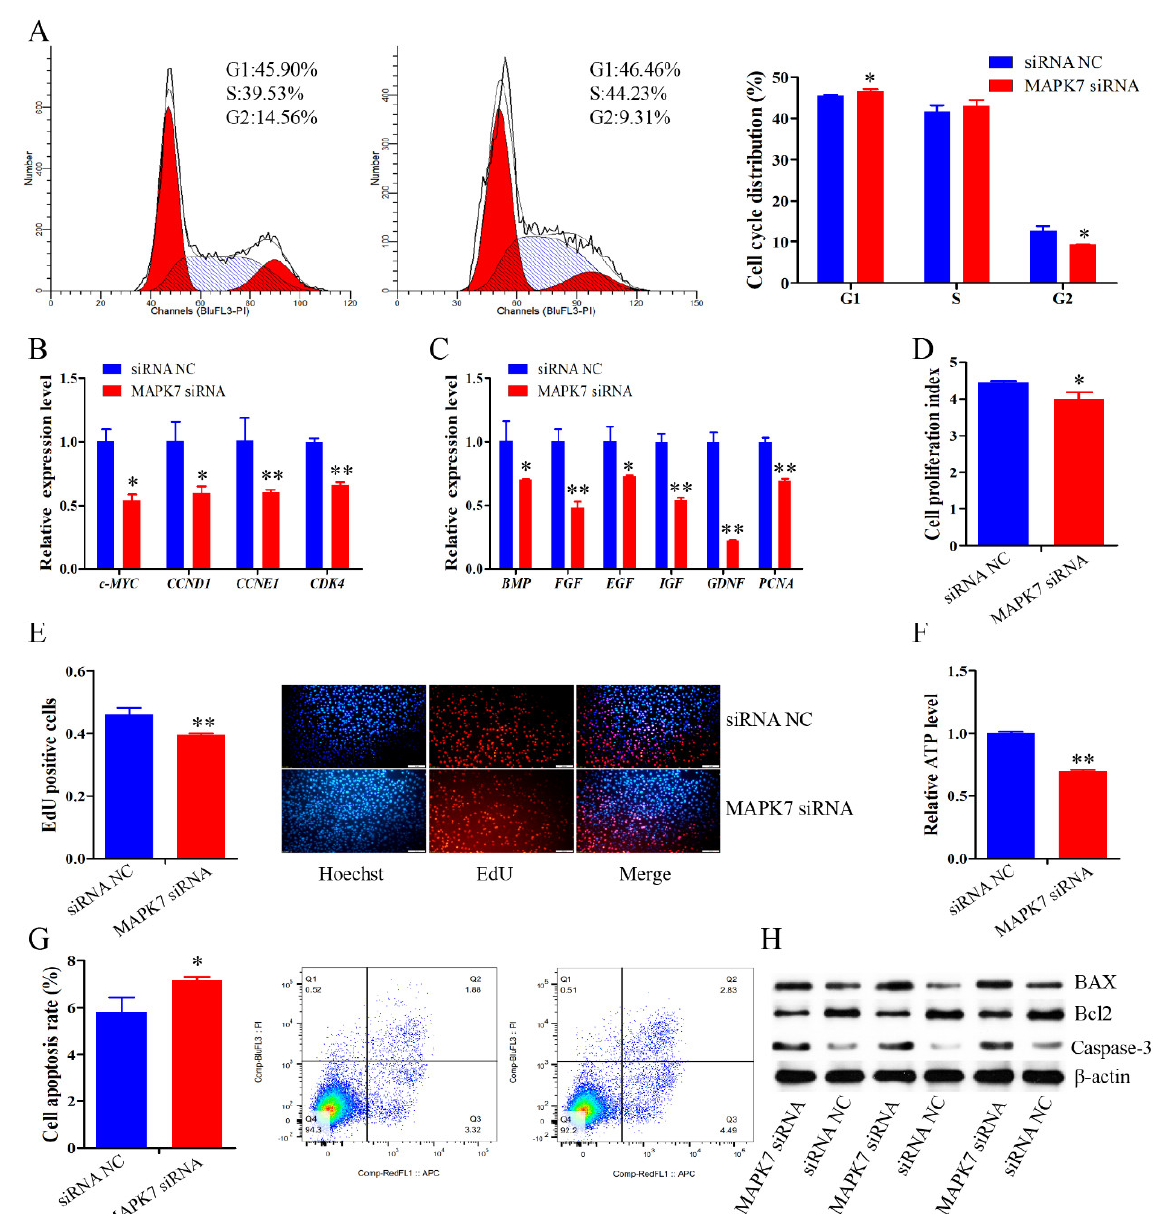
Figure 7. MAPK7 gene deficiency inhibits immature Sertoli cell proliferation and promotes cell apoptosis. A specific siRNA of MAPK7 gene was transfected in immature porcine Sertoli cells to knockdown its expression. ( A ) The cell cycle distribution was analyzed and then the proportion of cells in G1, S, and G2 phases were counted ( n = 3). ( B , C ) The mRNA expression of cell cycle-related genes ( B ) and cell proliferation marker genes ( C ) were measured using the qRT-PCR assay ( n = 3). The pig-TBP gene was used as the internal control. ( D , E ) CCK-8 ( D ) and EdU incorporation ( E ) assays were used to explore the effect of MAPK7 knockdown on the cell proportion ( n = 3). Representative images of EdU staining are listed. Scale bar = 200 μm. ( F ) The effect of MAPK7 knockdown on the relative ATP level ( n = 3). ( G ) The cell apoptosis rate was investigated using Annexin V-FITC/PI staining assay ( n = 3). ( H ) The protein expression of cell survival-related genes was determined using Western blot assay ( n = 3). The β-actin gene was used as the internal control. Data are presented as the mean ± S.D. * p < 0.05, ** p < 0.01.